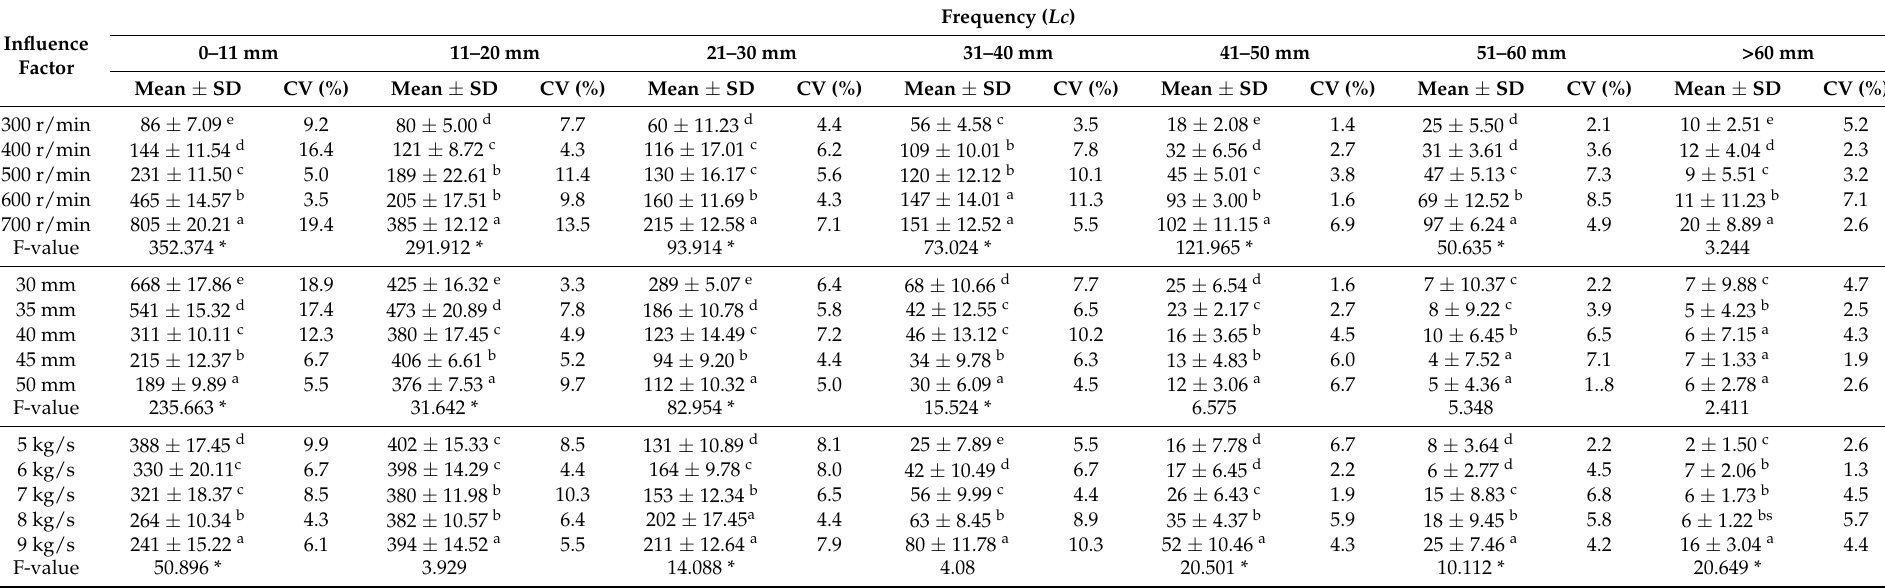
Table 3. Effect of process parameters on Frequency ( Lc ) of corn cobs and repeated measures analysis of variance.